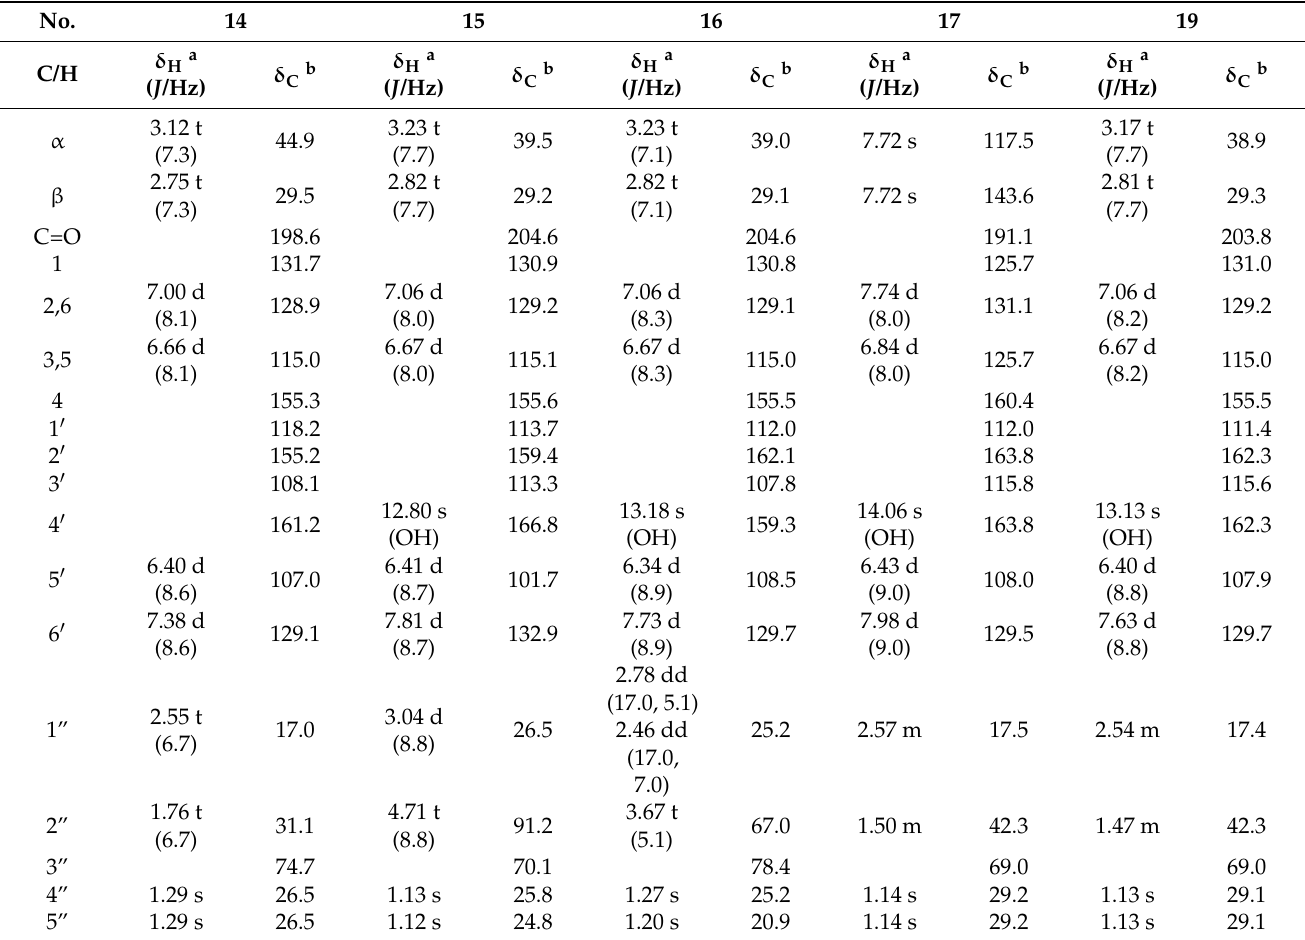
Table 3. 1 H- and 13 C-NMR data for 14 – 17 and 19 in DMSO- d 6